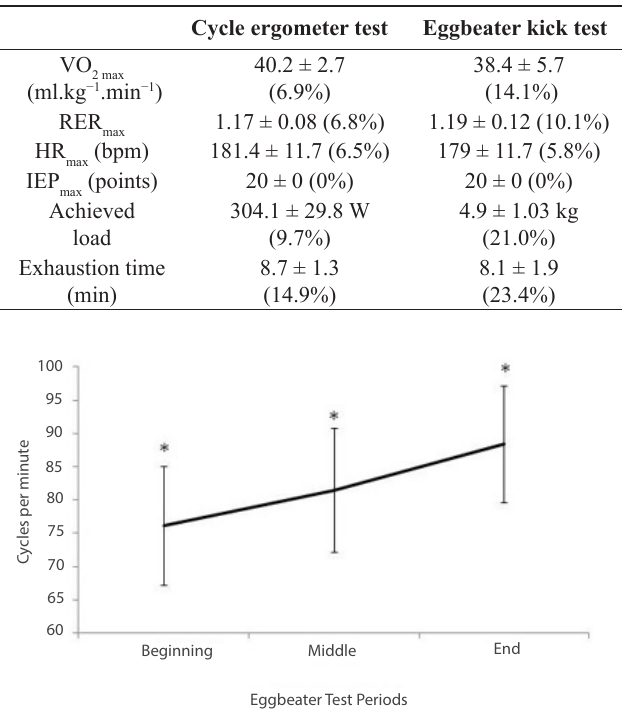
Figure 1. Eggbeater kick test cadence in cycles per minute in three periods (beginning, middle, end); n = 12; * p < 0.01 for all comparison